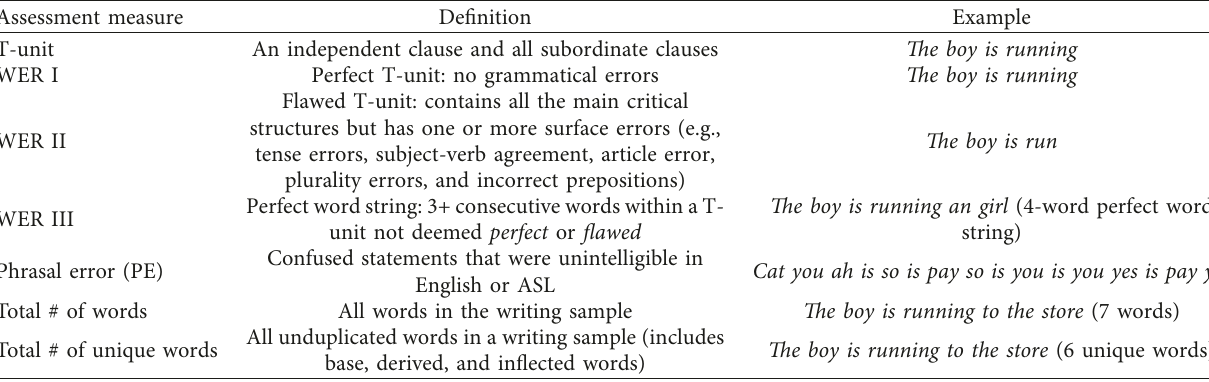
Table 2: Assessment measures, definitions, and examples.